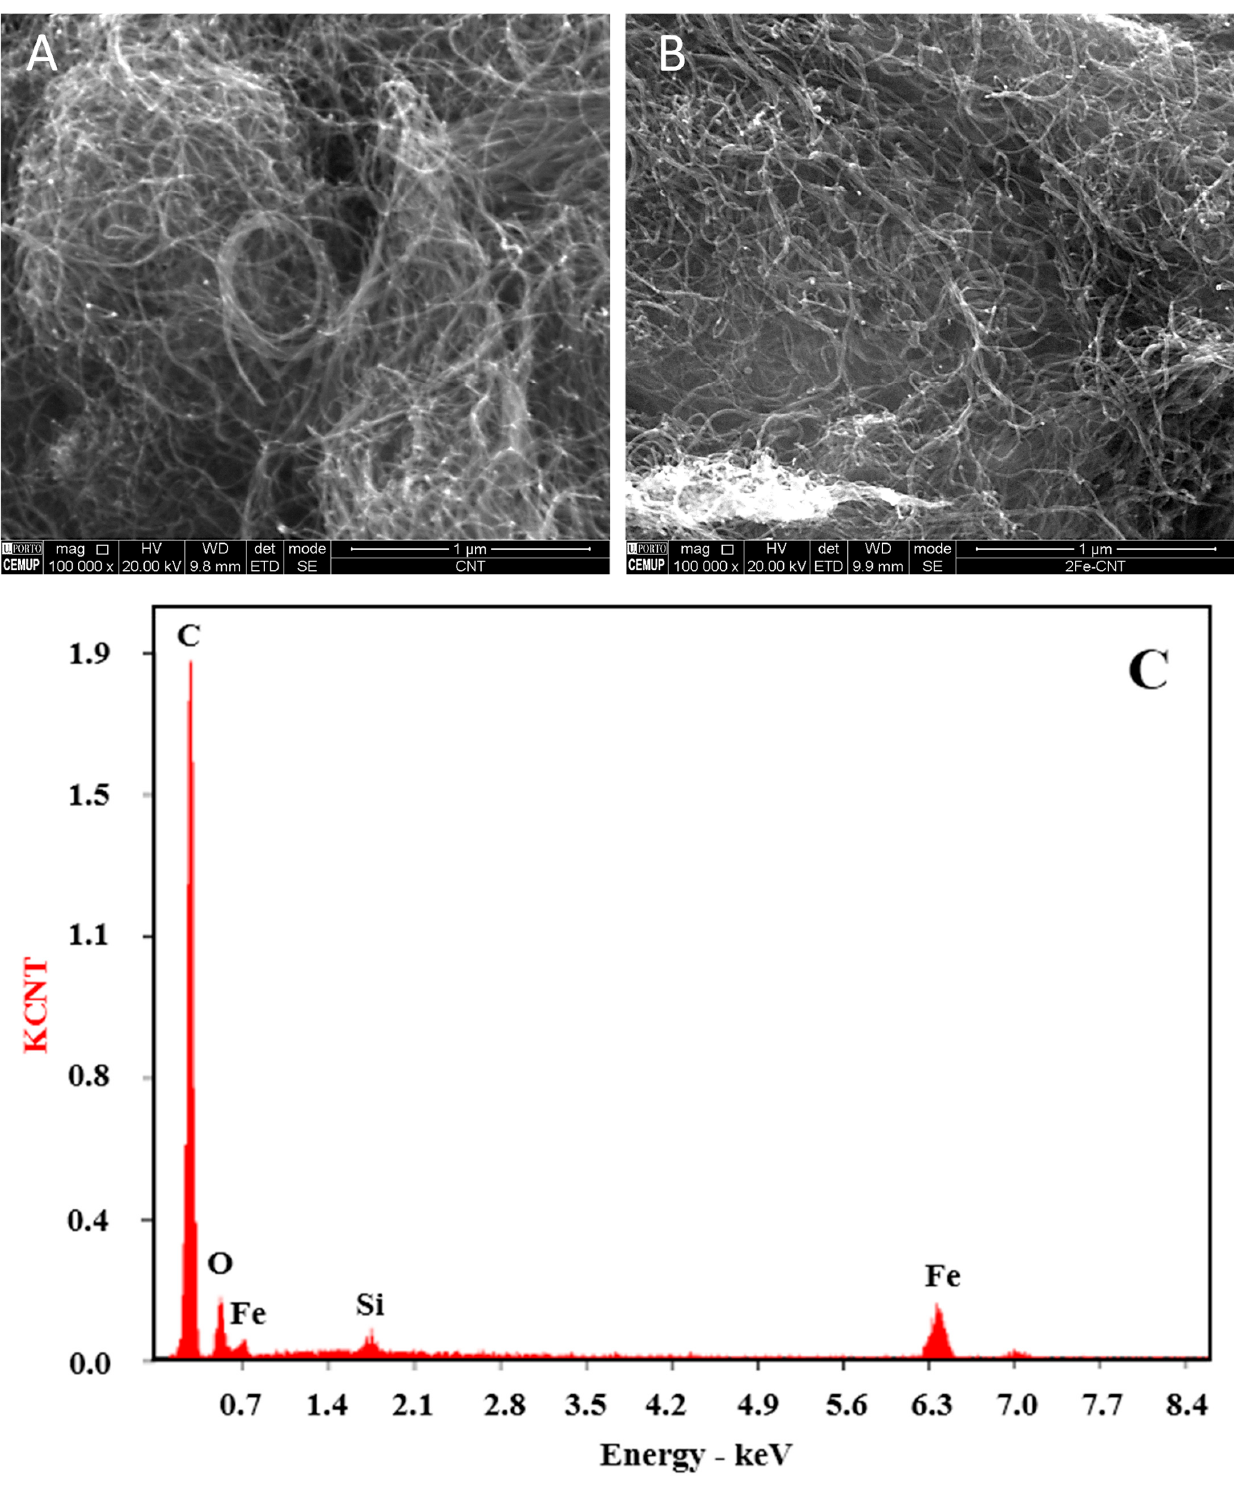
Figure 1. Scanning Electron Microscopy (SEM) images of ( A ) carbon nanotubes (CNT) and ( B ) CNT@2%Fe and ( C ) Energy Dispersive Spectroscopy (EDS) analysis of CNT@2%Fe sample.